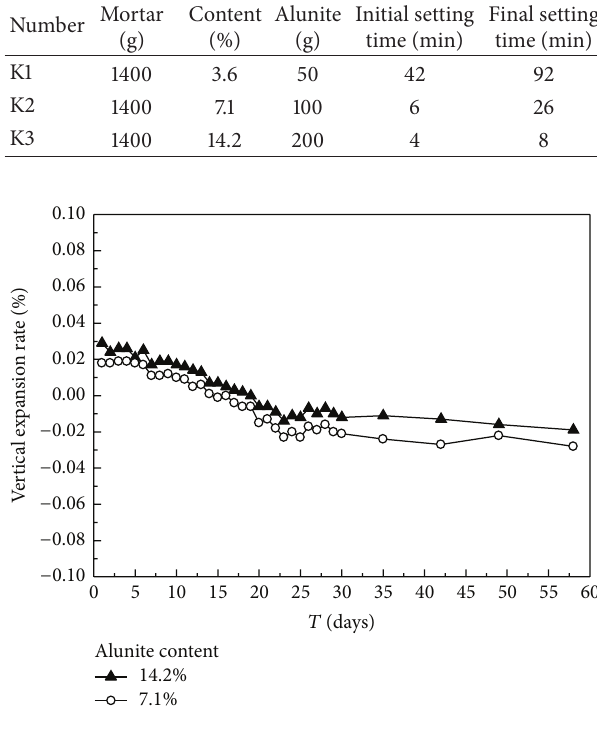
Figure 11: Effect of alunite content on expansion